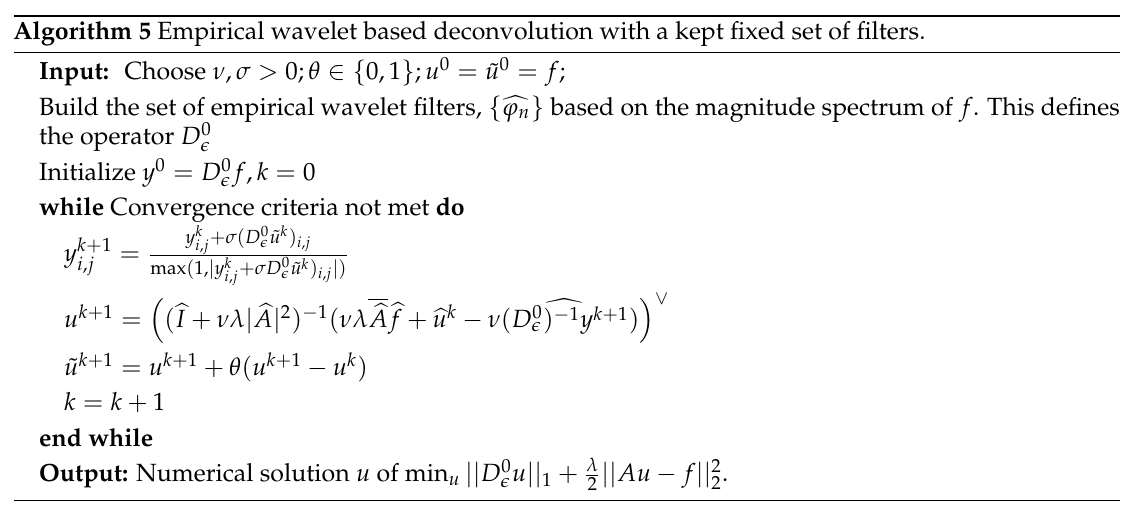
Algorithm 6 Empirical wavelet based deconvolution with sets of wavelet filters that are updated at each